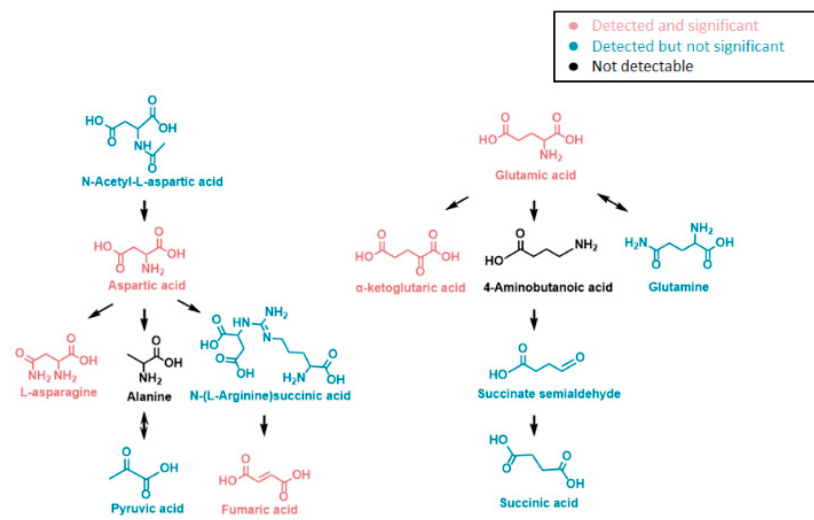
Figure 12. Alanine, Aspartate, and Glutamate Metabolites Affected in Their 13 C-Enrichment from Glucose by NAT1 KO in Breast Cancer Cells. Metabolites were detected in the alanine, aspartate, and glutamate biosynthesis pathways. Metabolites in black were not detected in this study, while the isotopologues of metabolites in pink showed significant abundance changes from NAT1 KO. Isotopologues of the metabolites in blue did not show significant abundance changes.